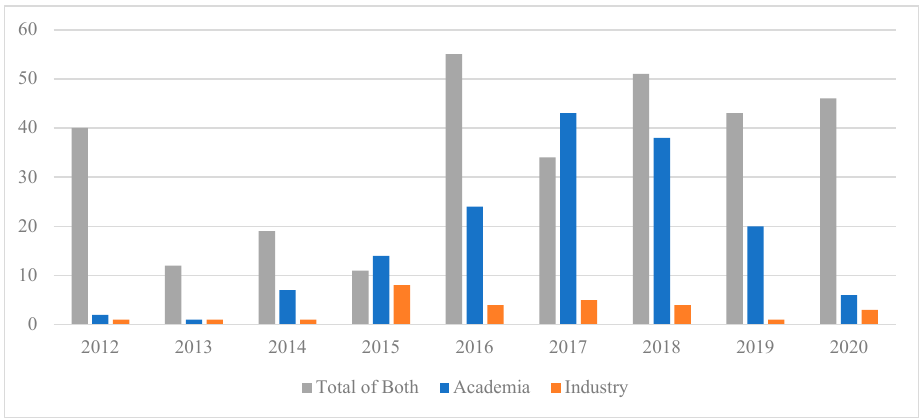
Figure 1. Year-wise article count.